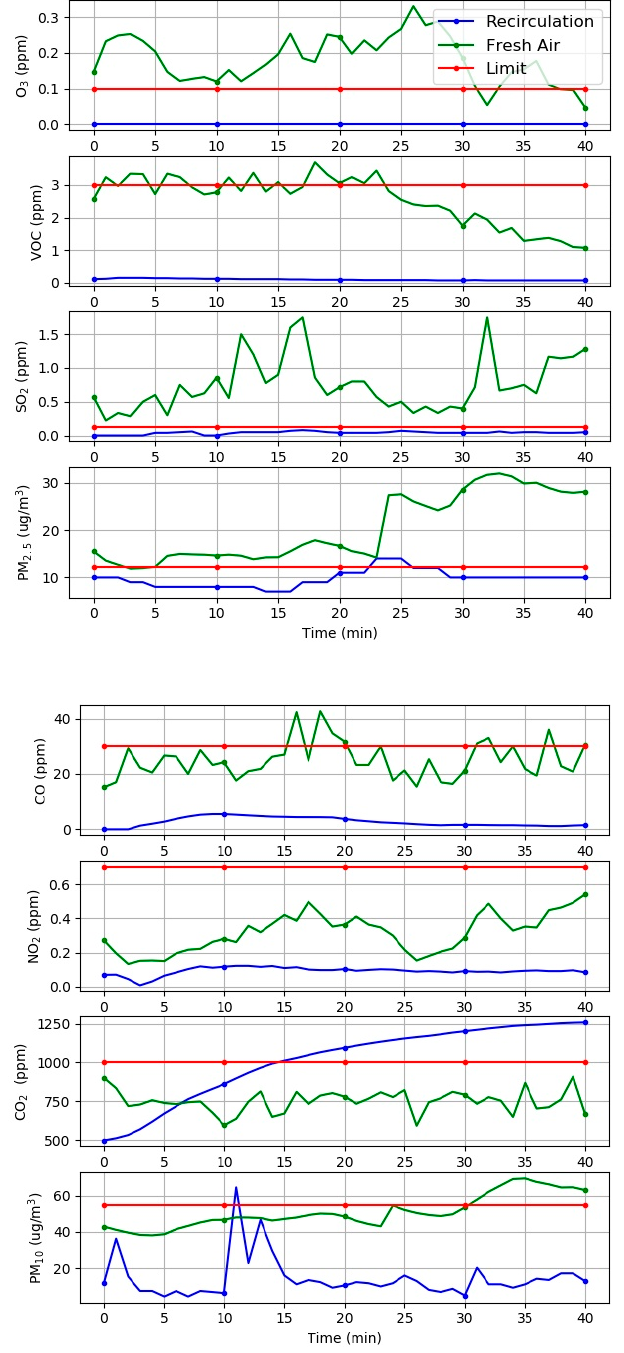
Figure 3. The common hazardous gases inside the vehicle cabin with the FA and RC ventilation modes. tion